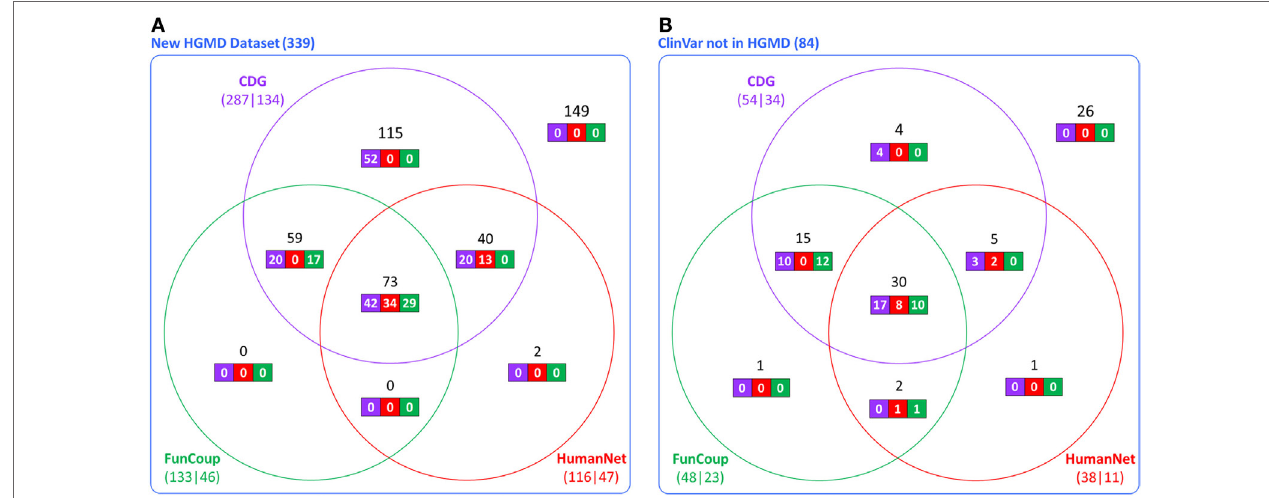
FIGURe 2 | Comparative performance of CDG, FunCoup, and HumanNet using (A) 339 new genes in human gene mutation database (HGMD) and (B) using 84 genes in ClinVar that are not in HGMD. The numbers below each method show the number of genes with at least one predicted gene (left) and how many were associated with the expected disease (right). Black numbers show the gene distribution across the three servers and white numbers show how many were associated with the expected disease in each server.